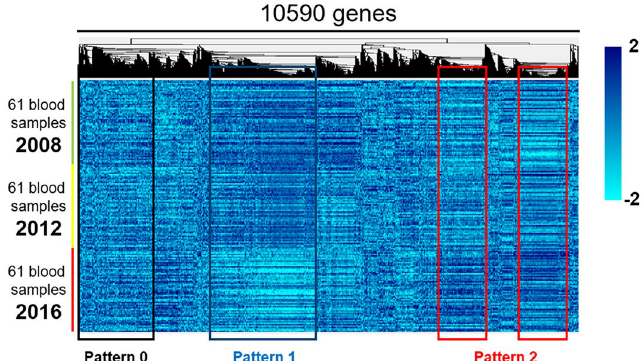
Figure 1. Heatmap of 10,590 genes that passed the preliminary filtering criteria, showing a distinct pattern of expression. The 10,590 genes that passed the filtration quality check suggested a pattern of stable gene expression (circumscribed by the black line; Pattern 0), whereas some genes had altered expression during the 8-year observation period. Specifically, there was a group of genes with downregulated expression in 2016 (circumscribed by the aqua blue line; Pattern 1) and a second group of genes with upregulated expression (circumscribed by the red line; Pattern 2) compared with 2008 and 2012. Blood samples from 61 individuals were used for each time point.